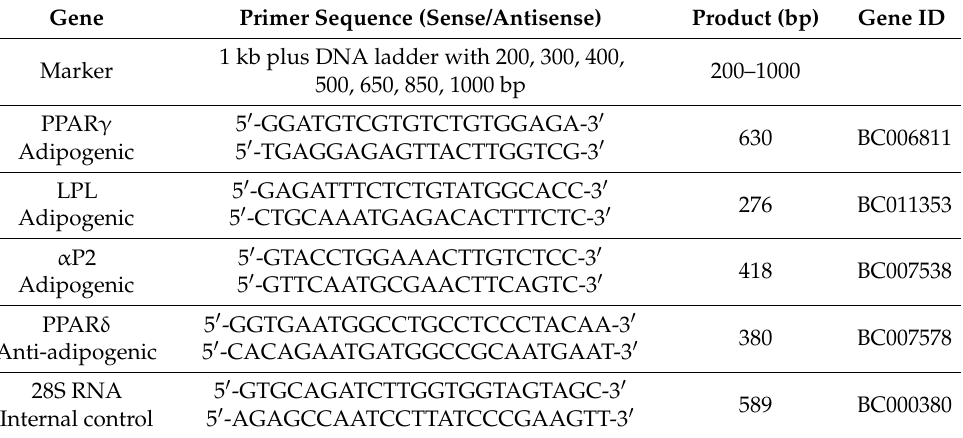
Table 1. PCR primers for adipogenic genes in human mesenchymal stem cell (hMSC) adipogenesis